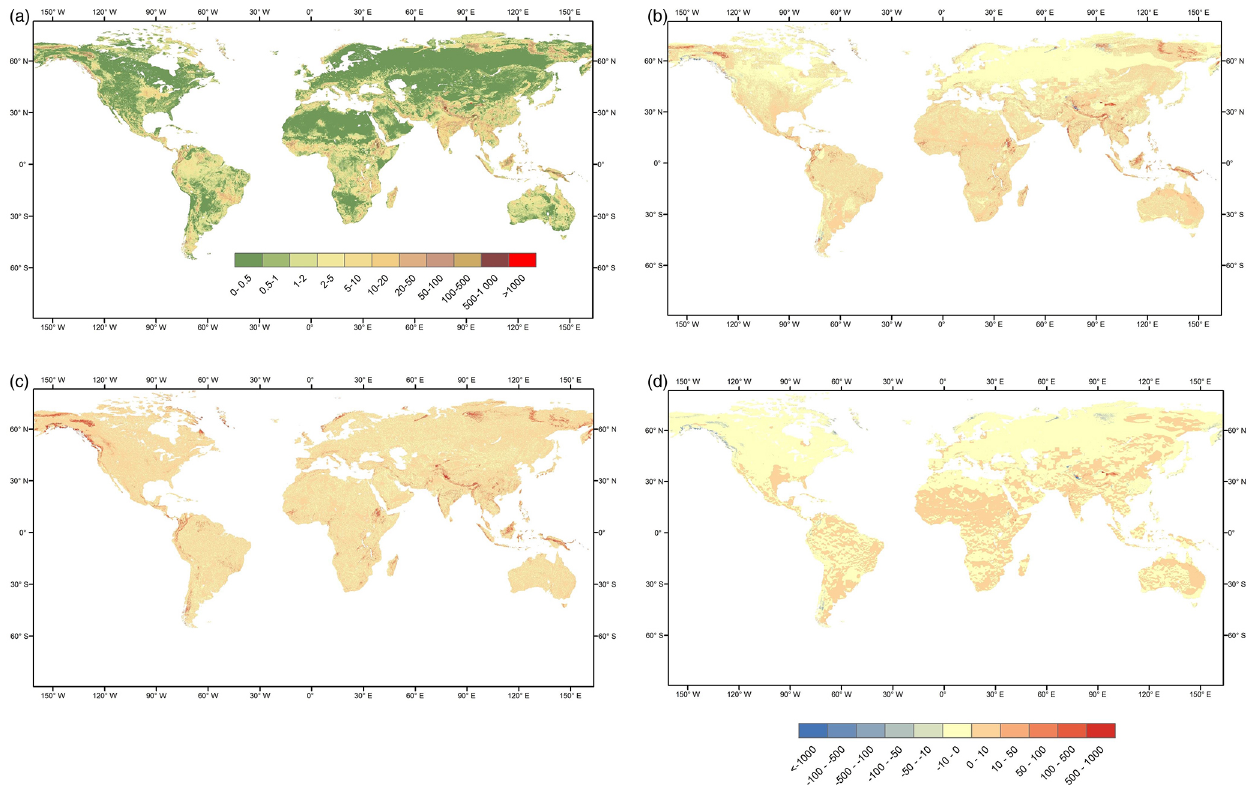
Figure 8. (a) Global yearly averaged erosion rates according to the fully adjusted RUSLE model; (b) a difference map between the fully adjusted and unadjusted RUSLE model; (c) a difference map between the adjusted S -RUSLE model and the unadjusted RUSLE model; (d) a difference map between the adjusted R -RUSLE model and the unadjusted RUSLE model. In panels (b) , (c) and (d) the reddish colours show an overestimation of the adjusted RUSLE model and yellow to bluish colours show an underestimation (resolution of all maps is 5arcmin and all units are in tha − 1 year − 1